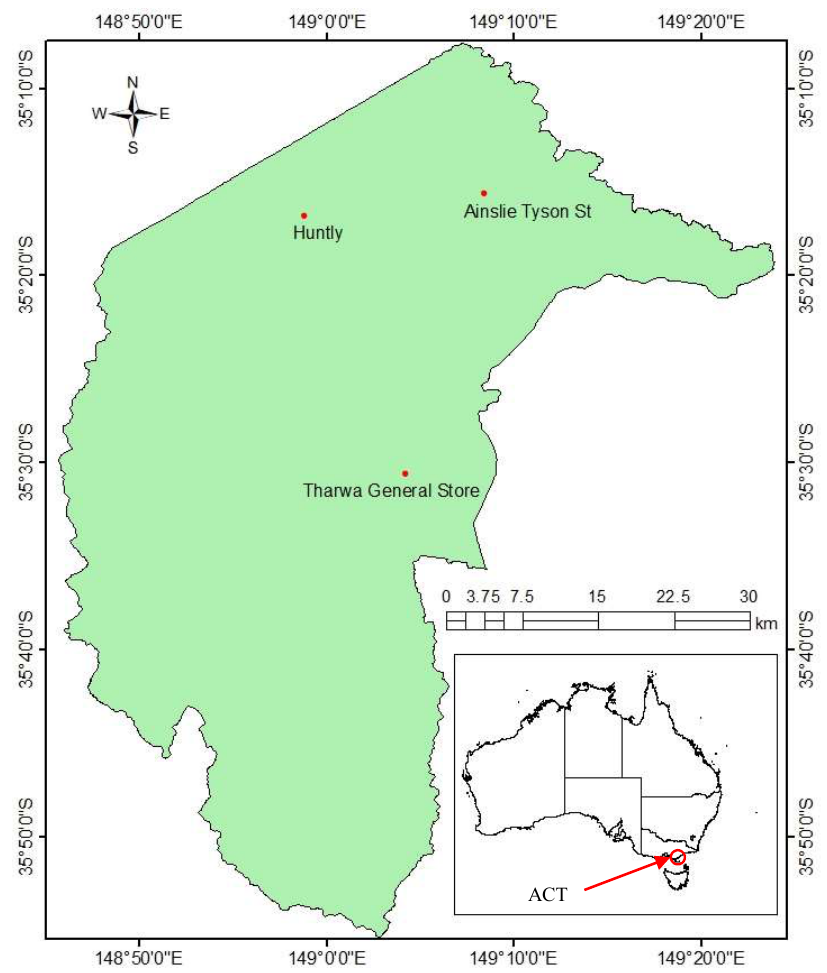
Figure 1. Selected rainfall stations in Australian Capital Territory.